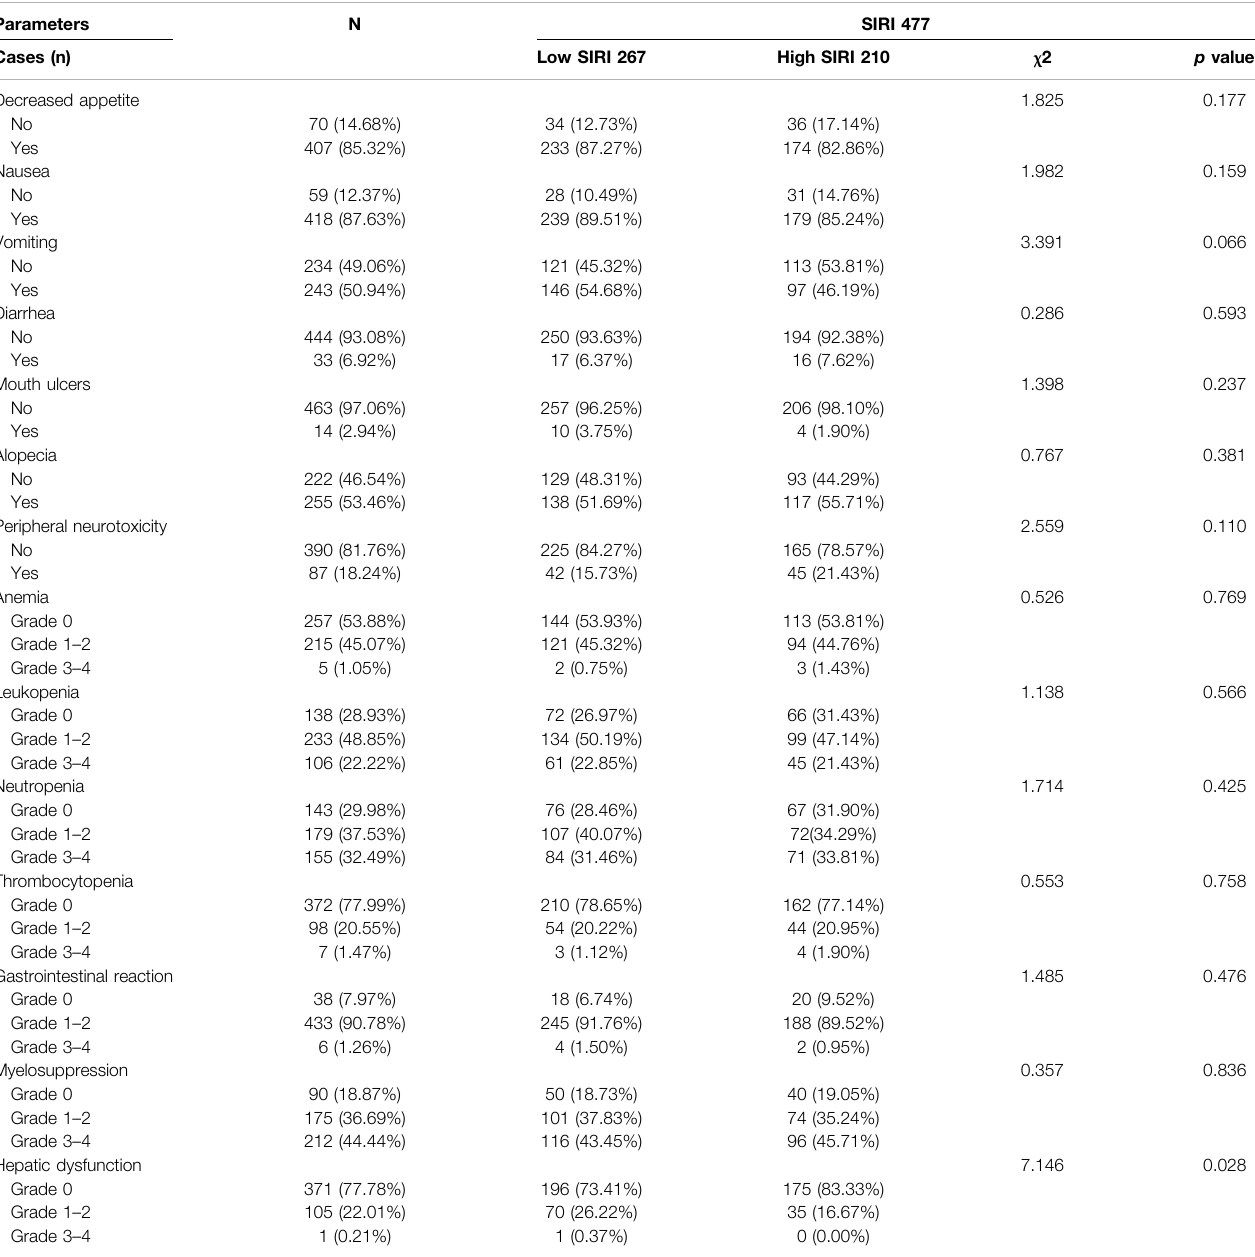
TABLE 5 | Correlation between SIRI and toxicity assessment. Parameters